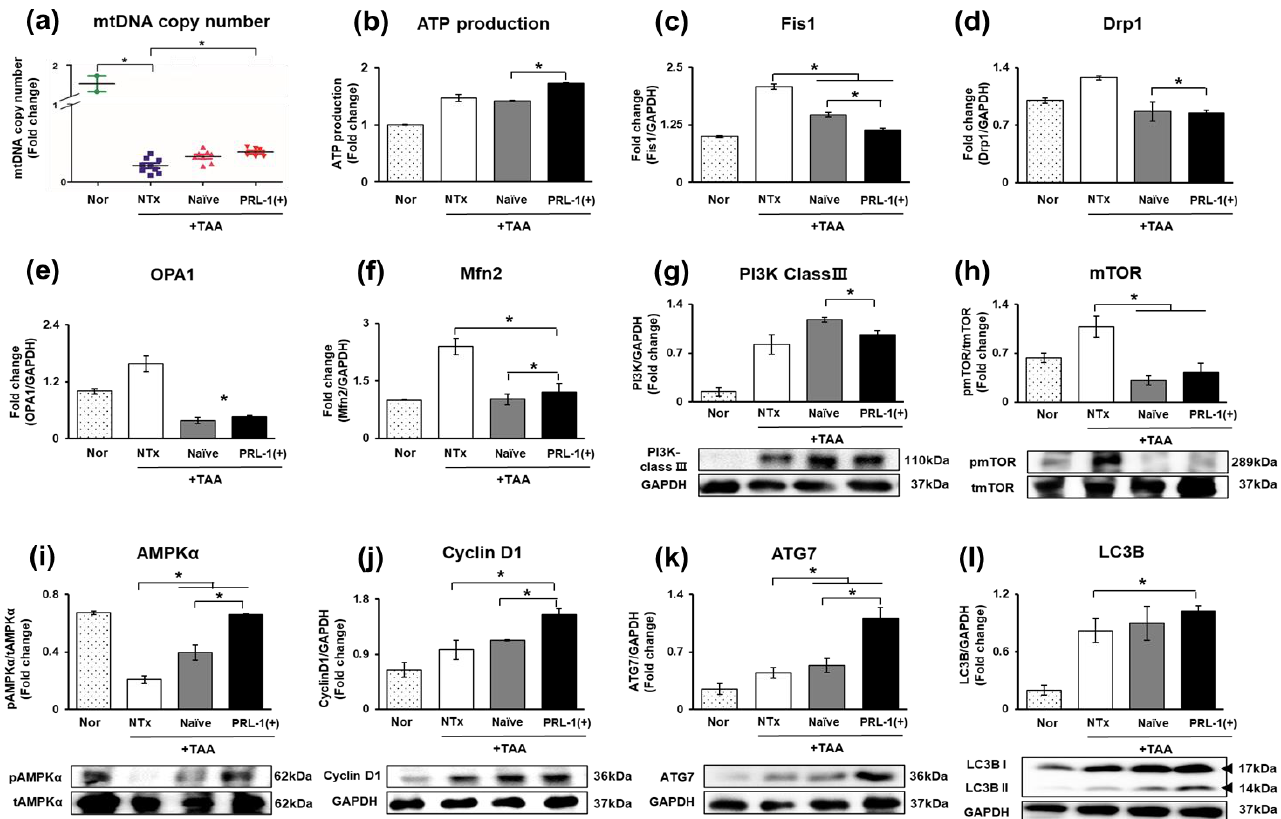
Figure 6. Autophagy in TAA-injured rat liver. The expression of mitochondrial homeostasis in TAA-injured rat liver by gDNA and ELISA. ( a ) mtDNA copy number, ( b ) ATP production. The expression of mitochondrial fission and fusion markers in TAA-injured rat liver by qRT – PCR ( c ) Fis1, ( d ) Drp1, ( e ) OPA1, ( f ) mfn2. The expression of autophagy markers in TAA-injured rat liver by Western blot ( g ) PI3K class Ⅲ , ( h ) mTOR, ( i ) AMPK α , ( j ) Cyclin D1, ( k ) ATG7, ( l ) LC3B.All experiments were repeated in duplicate to triplicate. * p < 0.05.